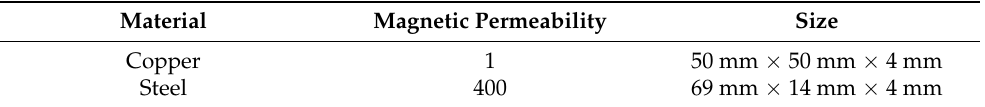
Figure 11. Metal foreign object. Table 6. Metal foreign object size.